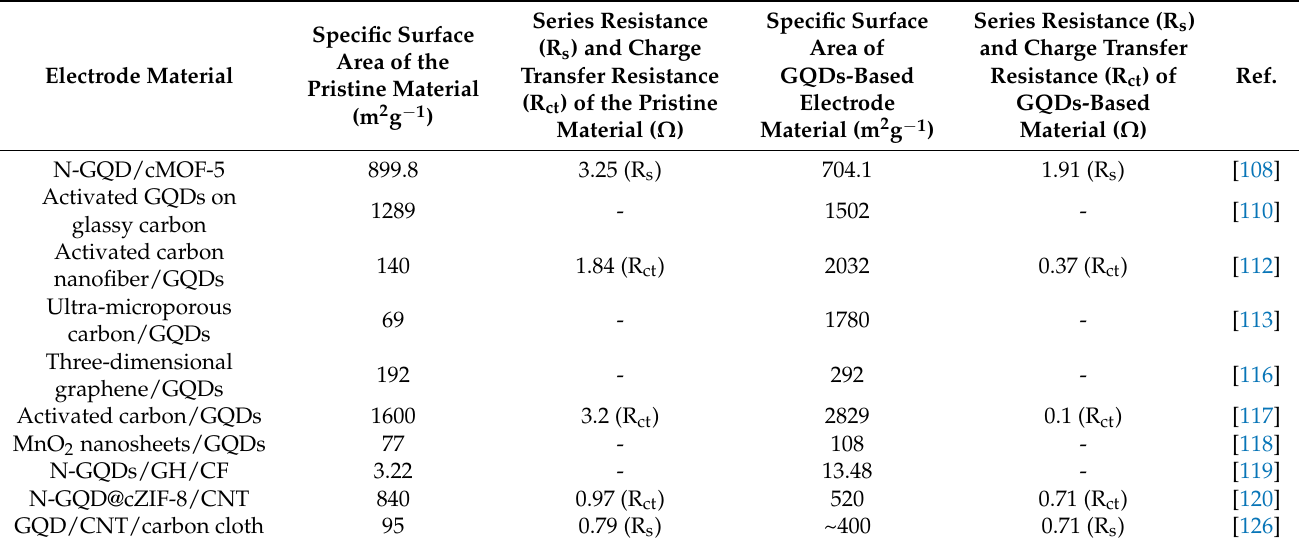
Table 1. Specific surface area and series resistance (Rs) or the charge transfer resistance (Rct) changes due to incorporation of GQDs in the composite electrode materials.